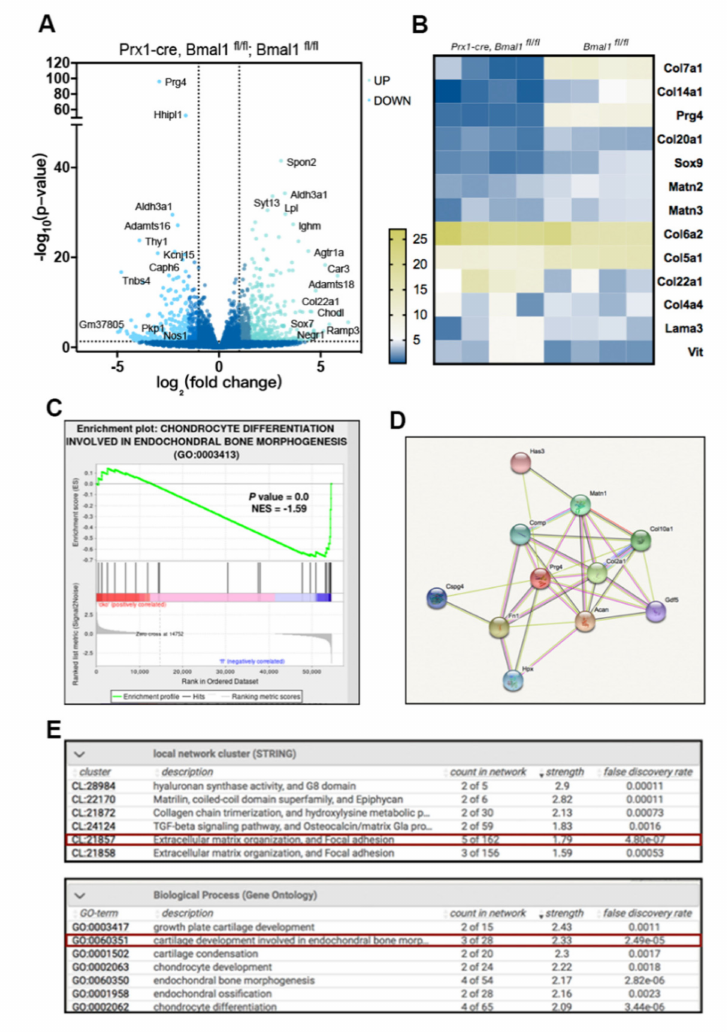
Figure 4. Bmal1 -deficent BMSCs damaged chondrocyte differentiation and extracellular matrix metabolism. ( A ) Volcano map of differential expressed mRNAs in Bmal1 fl/fl and Prx1-cre; Bmal1 fl/fl , Prg4 was the most significantly down-regulated gene. ( B ) Heatmap of representative chondrogenesis- associated genes (expressed as fold-change). ( C ) GSEA showed decreased enrichment on chondrocyte differentiation involved in endochondral bone morphogenesis in Bmal1 -deficient BMSCs. ( D ) The protein–protein interaction network of PRG4 using STRING. ( E ) PRG4-associated local network cluster (STRING) and biological process (Gene Ontology); red box indicates the most relevant functional